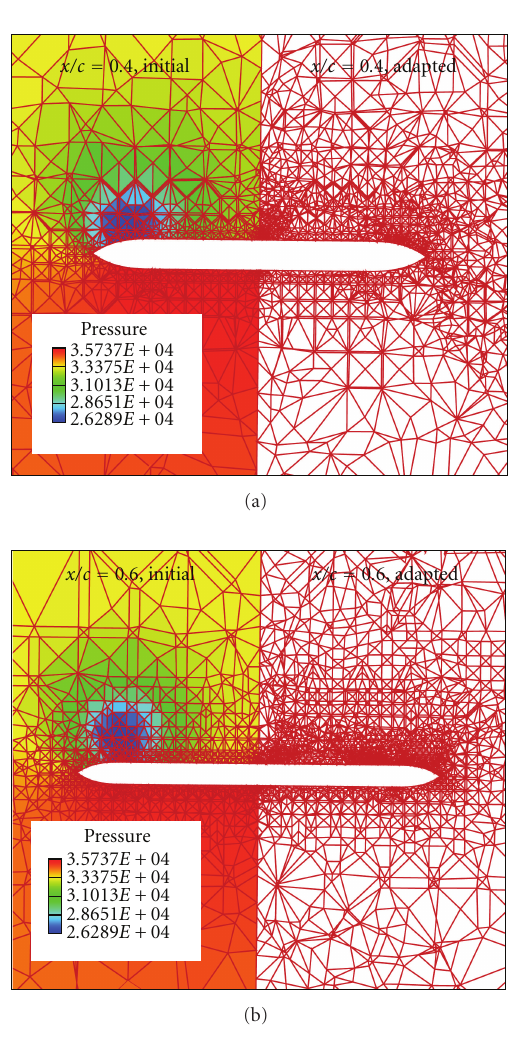
Figure 10: Comparisons of the grid resolution in space from two typical sections at x/c = 0 . 4 and x/c = 0 . 6 for the sharp leading- edge delta